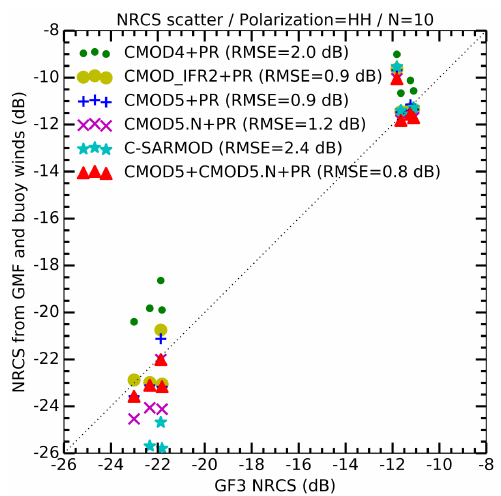
Figure 10. Same as Figure 7, but for HH polarization. The used PR model was developed using GF-3 data.